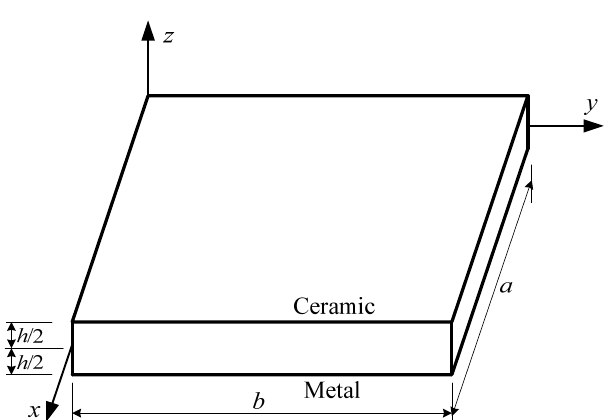
Figure 1. Functionally Graded Material (FGM) thin plate and Cartesian coordinates.